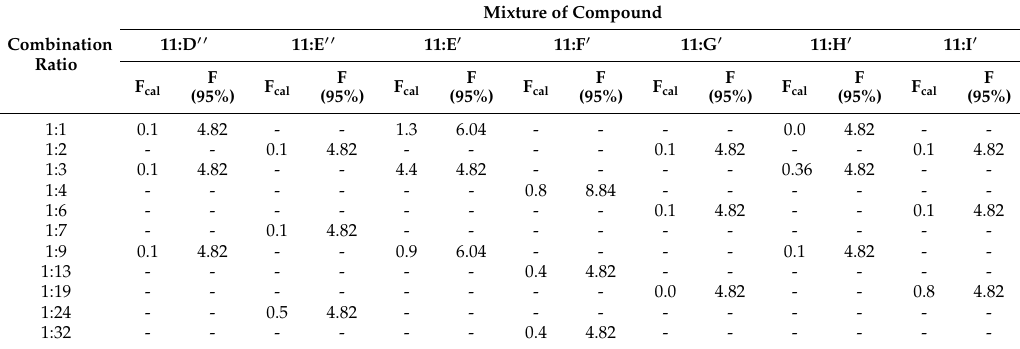
Table 7. Comparison of the additive and experimental regression lines for complex mixtures of compounds with the F-distribution ( α = 0.05) to distinguish two regression lines (if F cal > F there is a significant